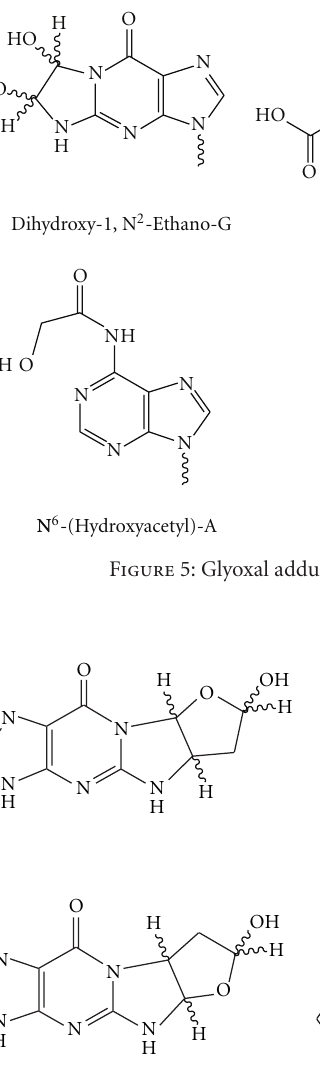
Figure 6: Reaction of 1,4-dioxo-2-butene to form bicyclic oxadiazabicyclo-(3.3.0) octaimine